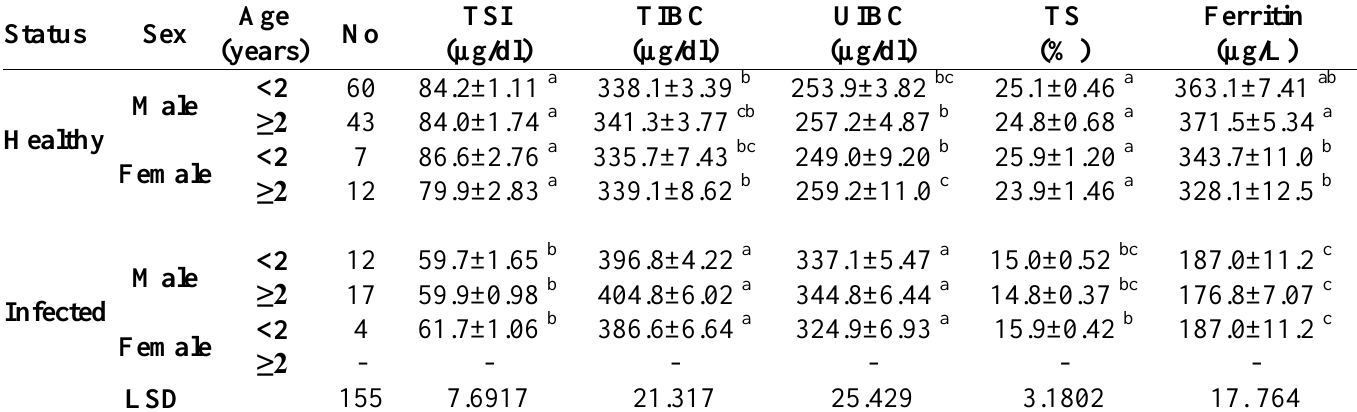
Table 1. Total serum iron (TSI), total iron-binding capacity (TIBC), unsaturated iron-binding capacity (UIBC), transferrin saturation (TS), and ferritin in Trypanosoma evansi infected male and female of different ages compared to